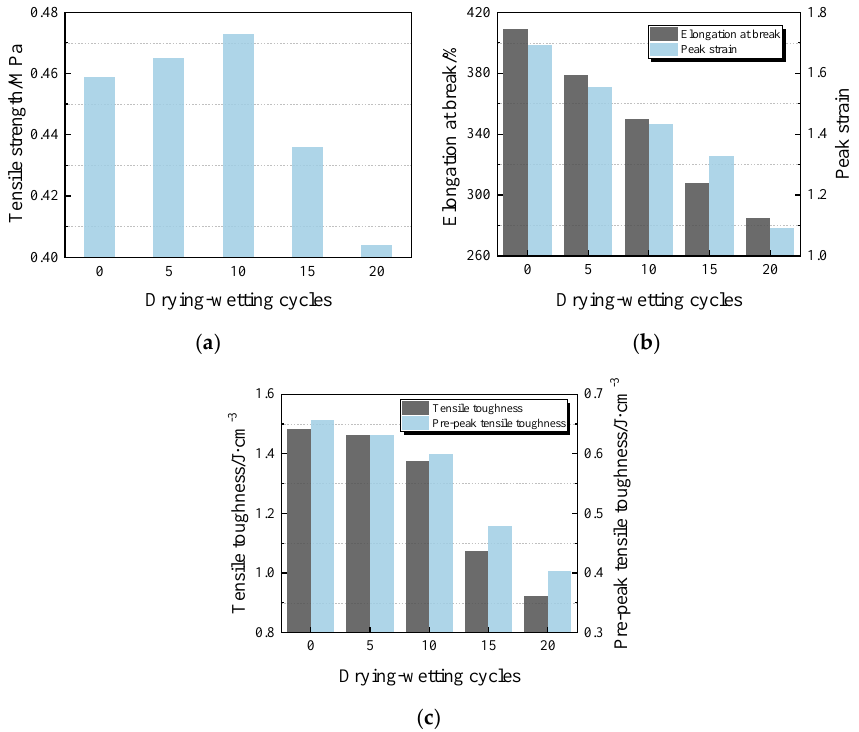
Figure 10. Tensile properties of PCFC under different drying–wetting cycles. ( a ) Tensile strength. ( b ) Elongation at break and peak strain. ( c ) Tensile toughness and pre-peak tensile toughness.